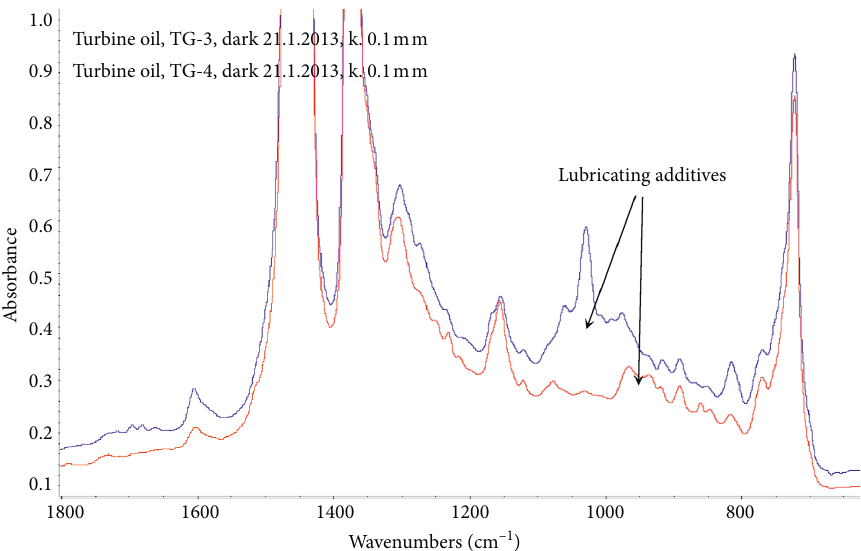
Figure 6: Comparison of the FTIR Spectra in terms of lubricant additives.